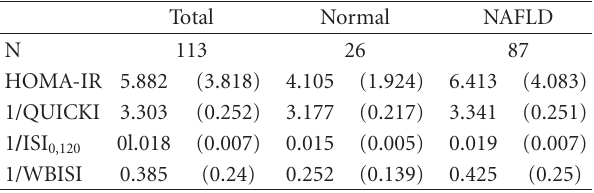
Table 4: Indices of Insulin resistance calculated from insulin and glucose levels during OGTT. Data represented as Mean ± ( SD ) . ∗ Total